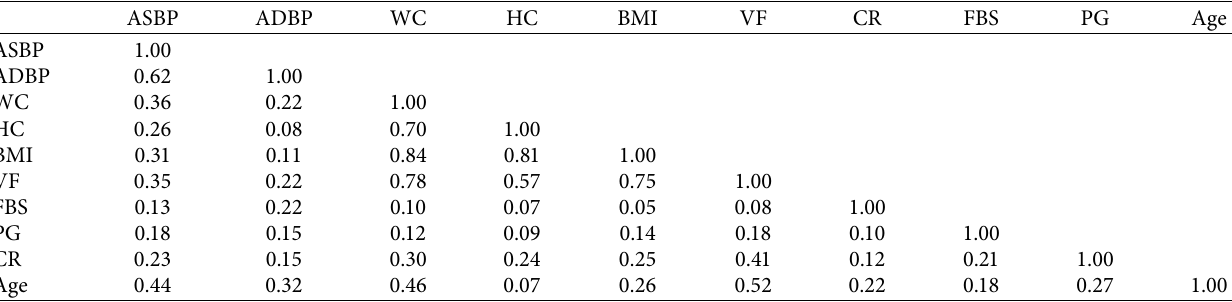
Table 2: The correlation matrix of the manifest variables.